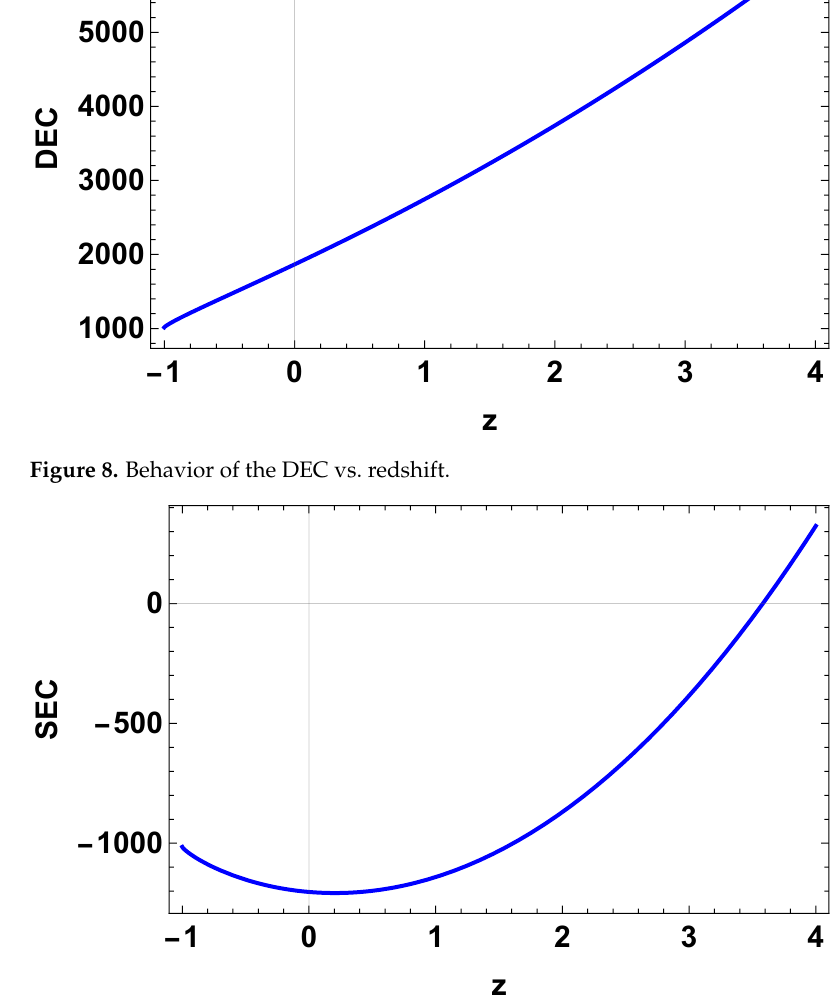
Figure 9. Behavior of the SEC vs.